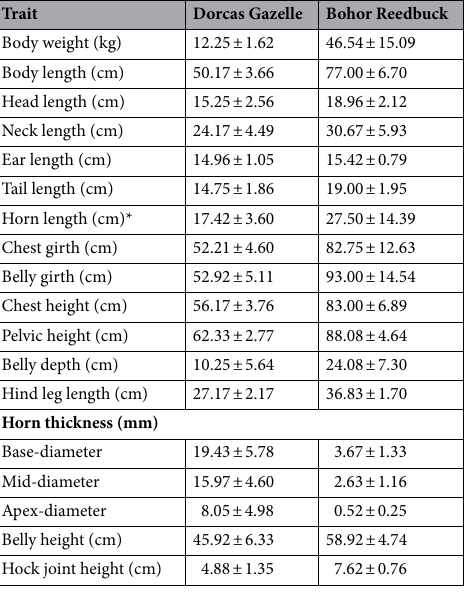
Table 1. Means (± SD) for body weight and some body measurements of Sudanese Dorcas Gazelle and Bohor Reedbuck antelopes. *Averages of horn length and thickness of reedbuck were calculated from males only, as there are no horns present in the females. SD Standard